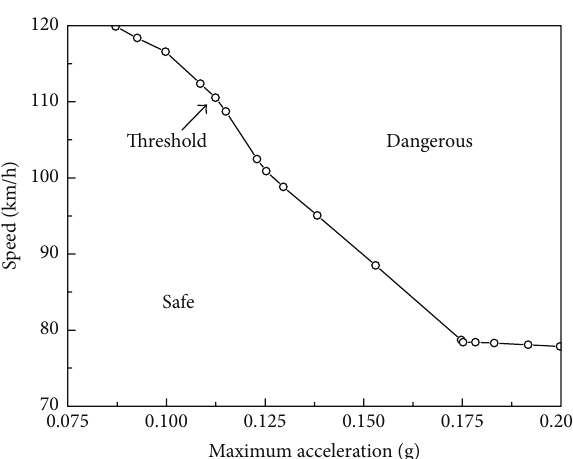
Figure 21: Critical train speed for running safety versus earthquake